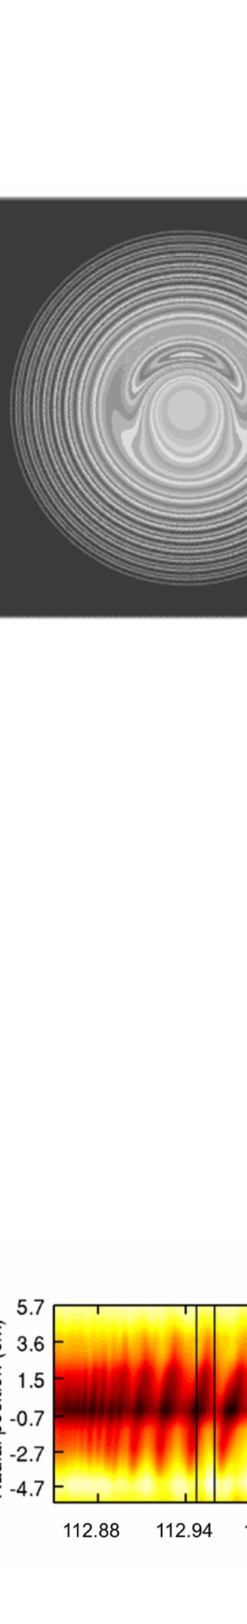
Figure 7. The contour plot of the ‘ n sigma ’ ( a ) and the evolution of the relative profile ( b ) during MHD activity during MHD mode growth leading to the collapse of the plasma pressure profile after t > 113.06 ms (reprinted from [9], with the permission of AIP